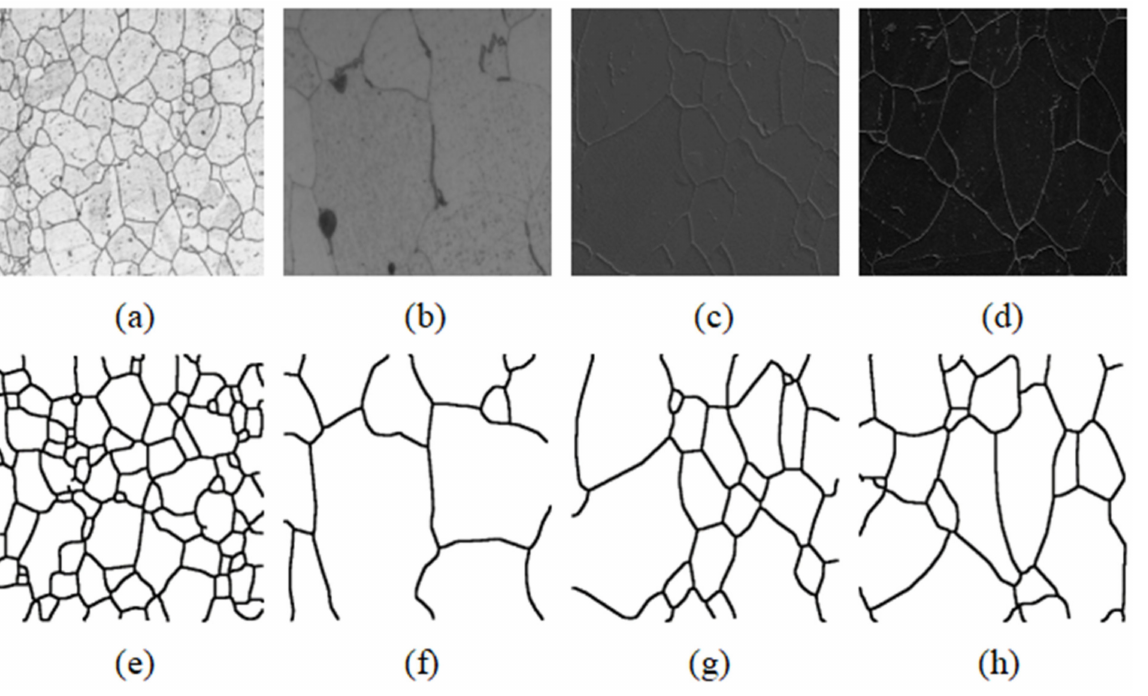
Figure 4. Examples of metallographic images. ( a – d ) Four metallographic images and ( e – h ) prepro- cessed